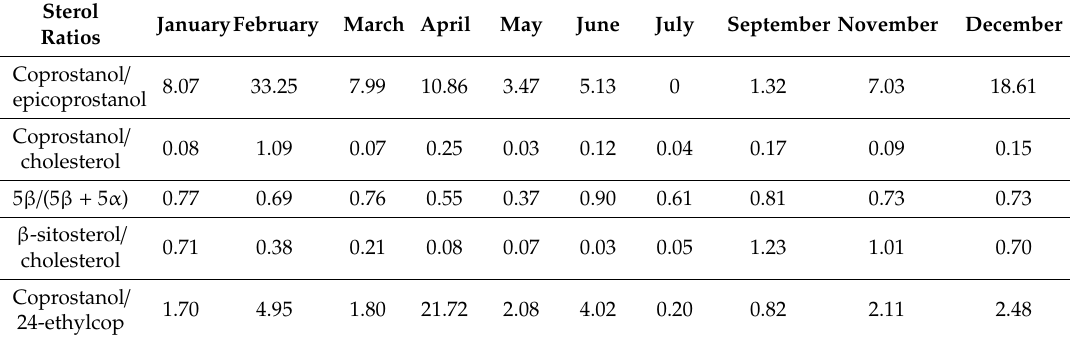
Table 4. Ratios of sterols for water samples collected from above the oyster beds (Site 4) over 12 months. Sterol Ratios